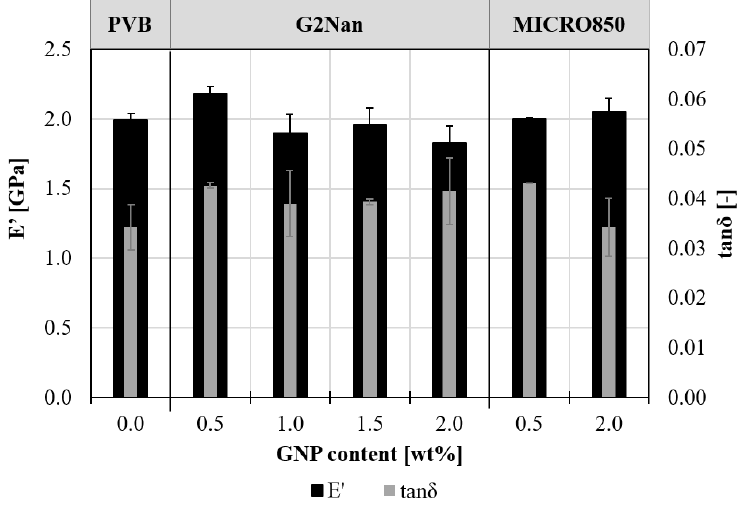
Figure 5. Comparison between storage modulus and damping ratio at room temperature of nano- composites. In the case of G2Nan composites, a maximum storage modulus of 2.3 GPa ( E’ ) is